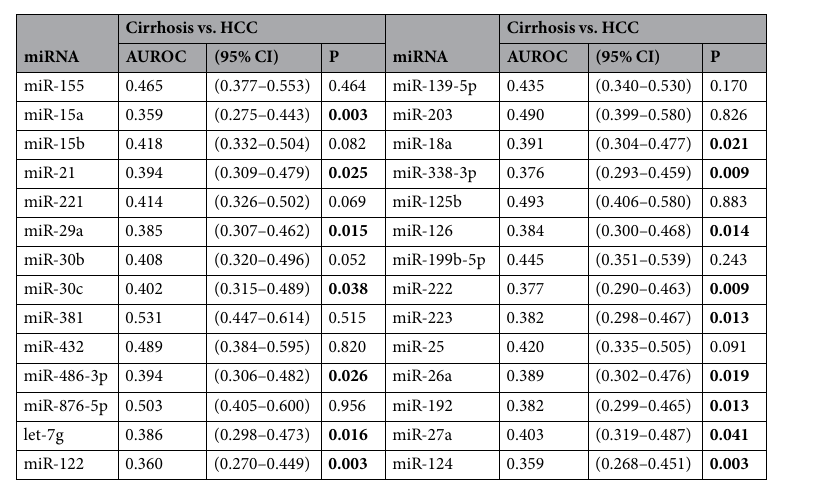
Table 5. Univariate analysis of miRNA levels in association with HCC using the receiver operating characteristic curves. A total of 16 miRNAs has P < 0.05 (shown in bold